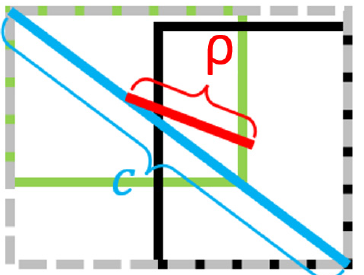
Figure 13. The similarity between the prediction box (green) and the real box (black) adopted by CIoU.